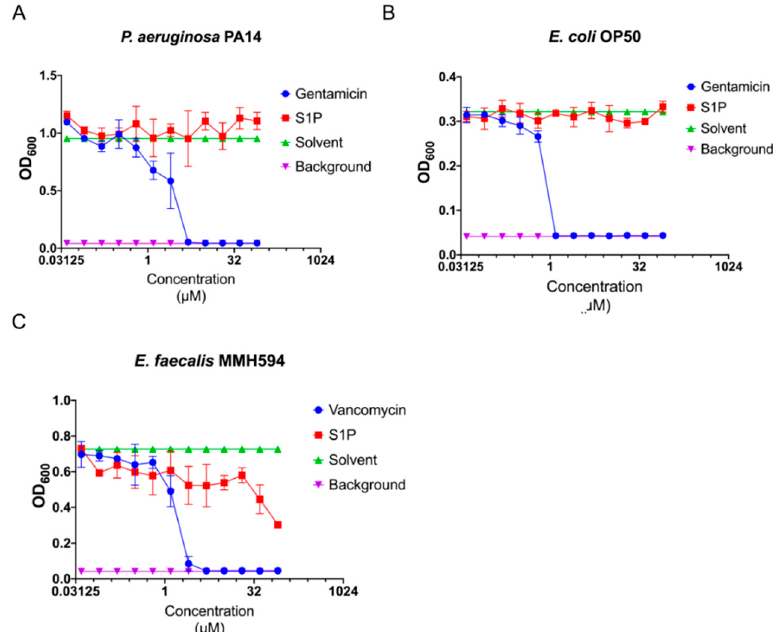
Figure 4. Spingoshine-1-phophate has limited antibiotic activity on E. faecalis MMH594 but not on Gram (–) bacteria. Growth of P. aeruginosa PA14 ( A ), OP50 ( B ), and MMH594 ( C ) exposed to antibiotics, gentamycin or vancomycin, solvent (methanol), and S1P at various concentrations after 18 h in Luria Broth or Brain Heart Infusion media. OD600, optical density at 600 nm. 2.4. S1P Signaling Depends on p38 MAPK Pathway and the Transcription Factor hlh-30